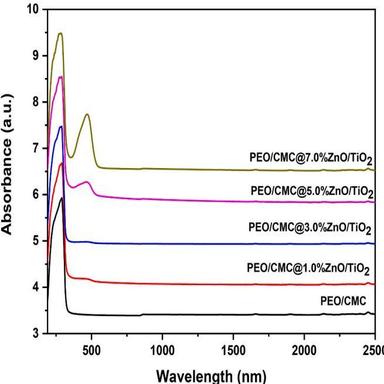
The UV/vis spectroscopy of PEO/CMC composite, PEO/CMC doped with 1.0, 3.0, 5.0 and 7.0 wt% of ZnO/TiO2 NPs.